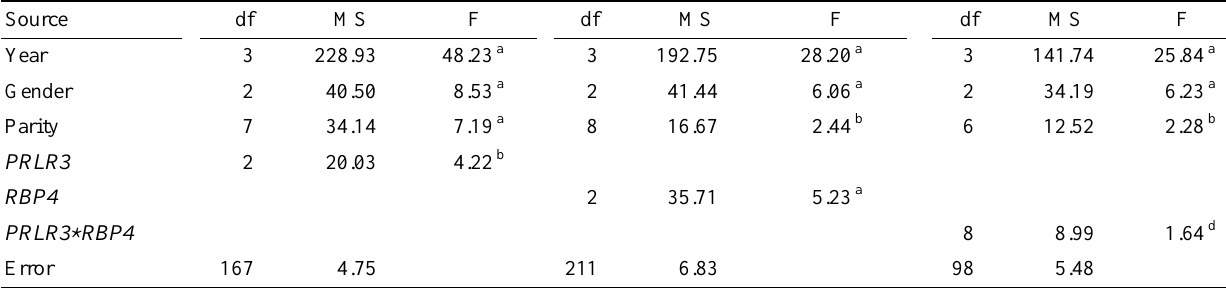
Table 4. Analysis of variance for back fat